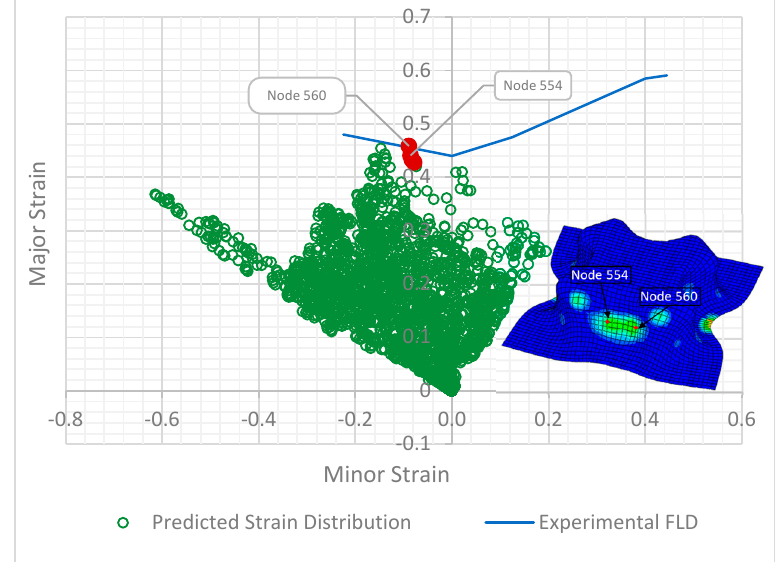
Figure 12. Distribution of strains at different locations.